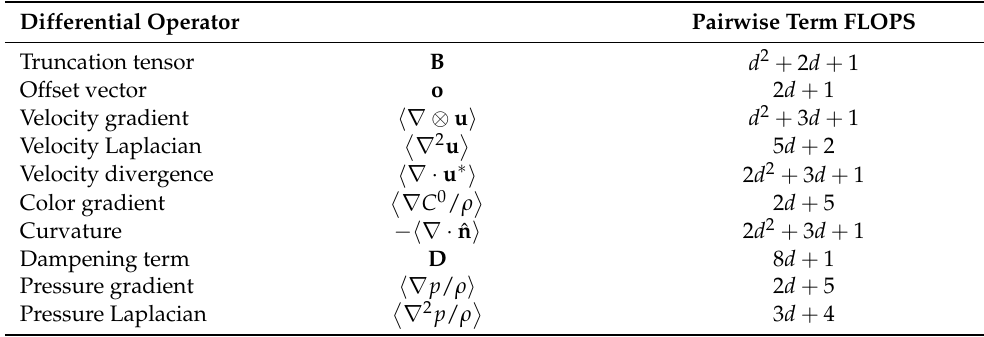
Table 1. FLOPS per pairwise interaction for all GFD operators utilized in this scheme for systems in dimension d